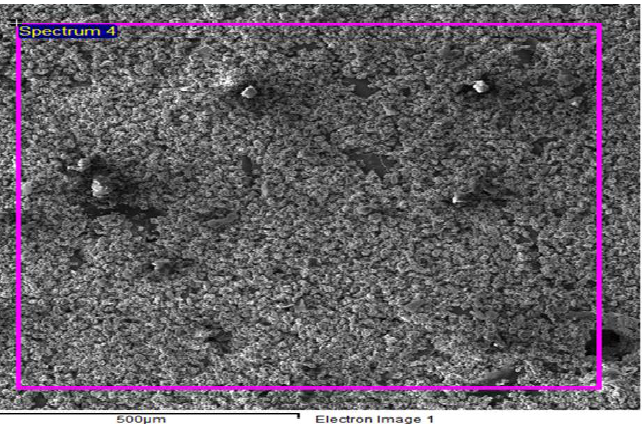
Figure 4 . SEM image of Al + 40 % SiC sintered at 1100 °C showing agglomeration of particles and Figure 4. SEM image of Al + 40% SiC sintered at 1100 ◦ C showing agglomeration of particles and porosity.